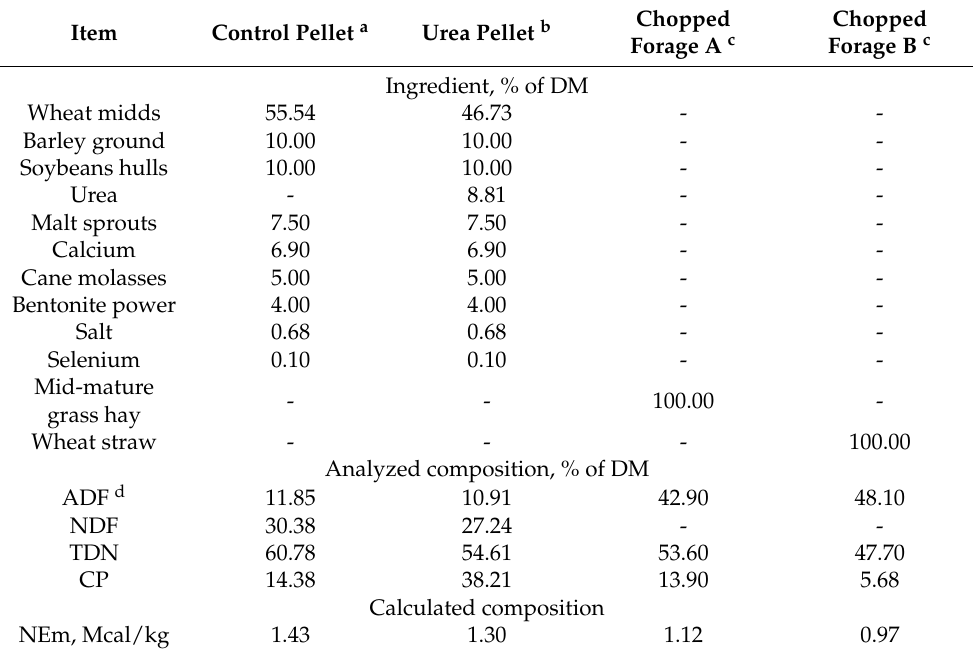
Table 1. Ingredients and chemical composition of feed offered to cows from day 28 of gestation to